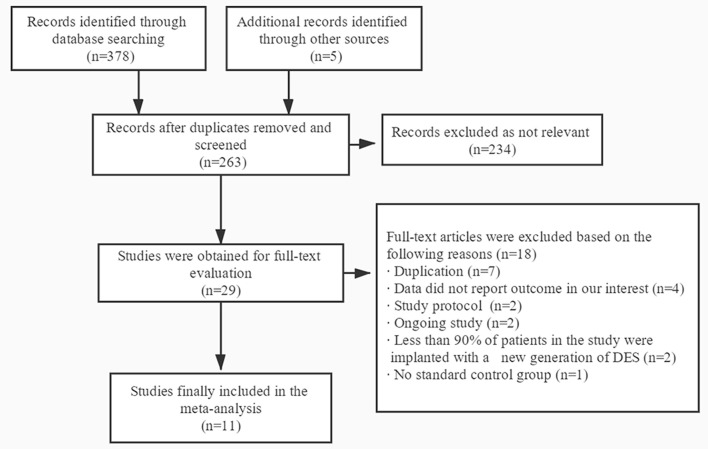
Flow diagram of literature search.